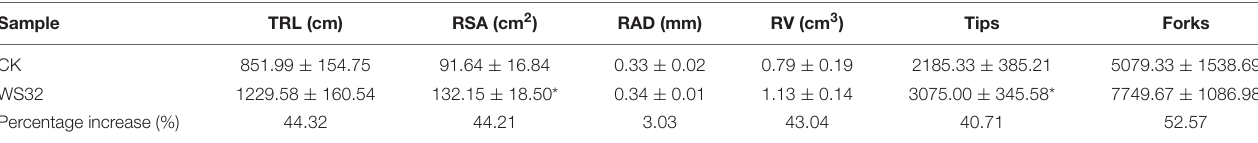
FIGURE 1 | Root morphology of wheat seedlings after 25 days of growth. CK: root system of an uninoculated wheat plant. WS32-1, WS32-2, and WS32-3: root systems of wheat plants inoculated with WS32. TABLE 3 | Effects of strain WS32 on wheat root growth collected on day 25 in rhizobox